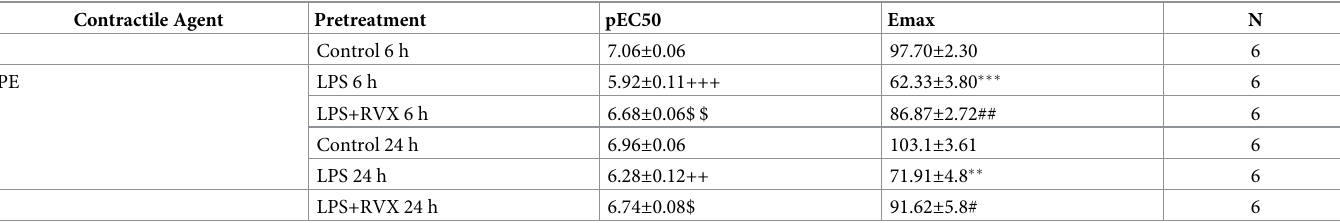
Table 1. Role of RVX on the vasoreactivity of aortic rings obstained from rats sacrificed 6 h and 24 h post LPS to PE-induced dose dependent contractions. Contractile